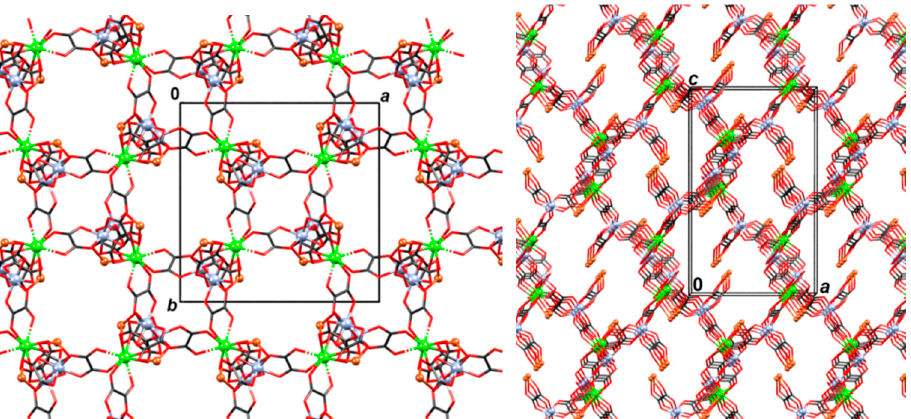
Figure 7. Two views of the 3D coordination polymer {[CaCr 2 Cu 2 (phen) 4 (C 2 O 4 ) 6 ]·4CH 3 CN·2H 2 O} n ( 3 ). Phenanthroline moieties and uncoordinated solvent molecules have been omitted for clarity.